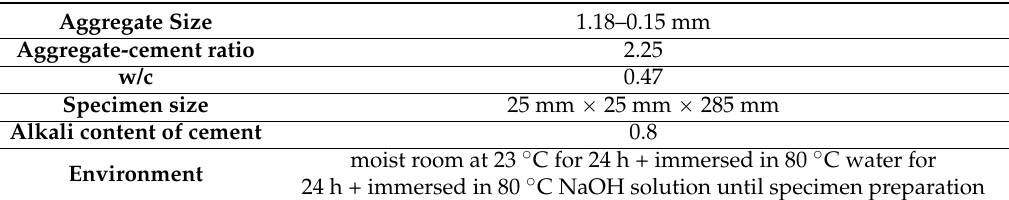
Table 1. General description of specimens used for this study.